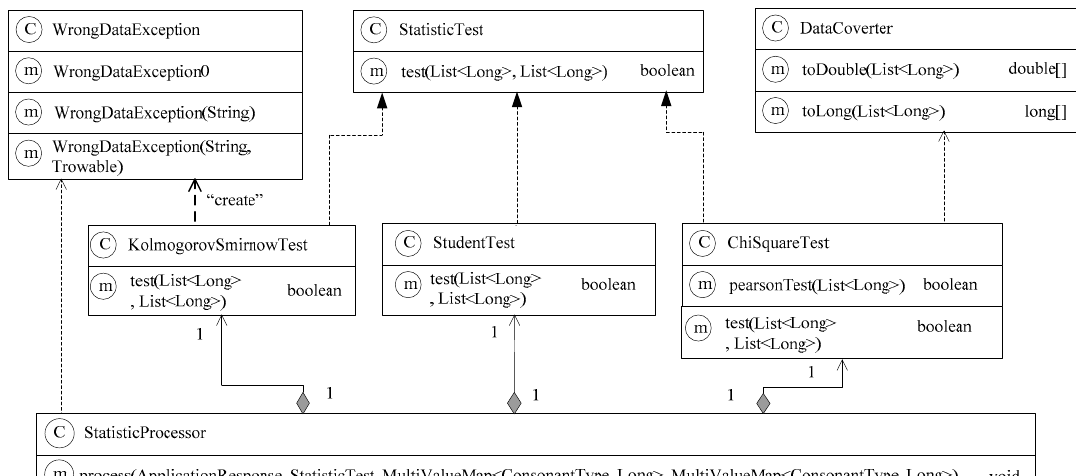
Figure 4. A diagram of the system classes for the statistical processing of a sample.